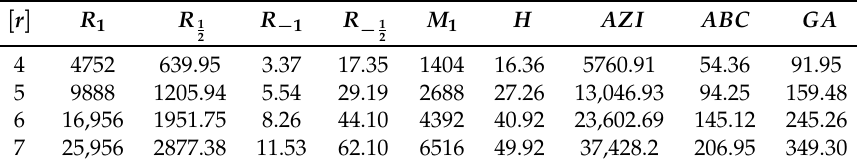
Table 6. Numerical computation of all indices for THDN 3 ( r ) .